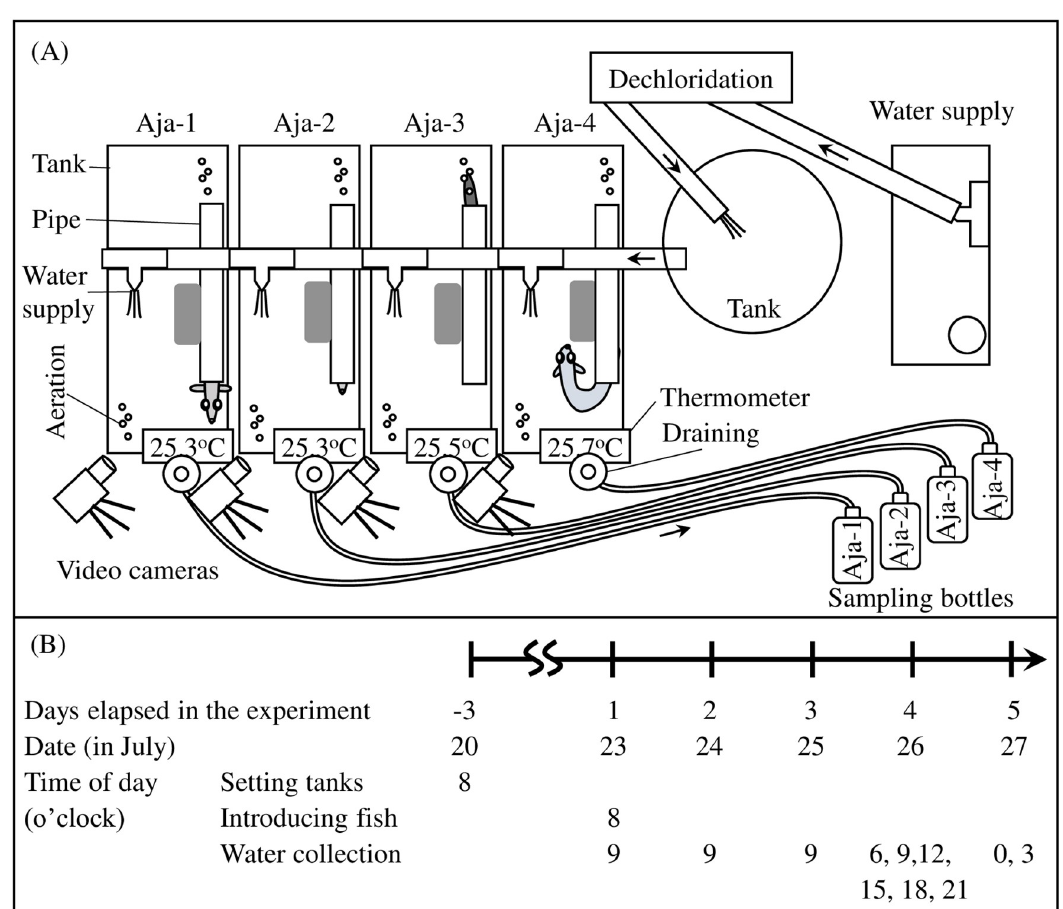
Fig 1. (A) Schematic drawing of the experimental tank system and (B) time schedule. Arrows in (A): Water flow